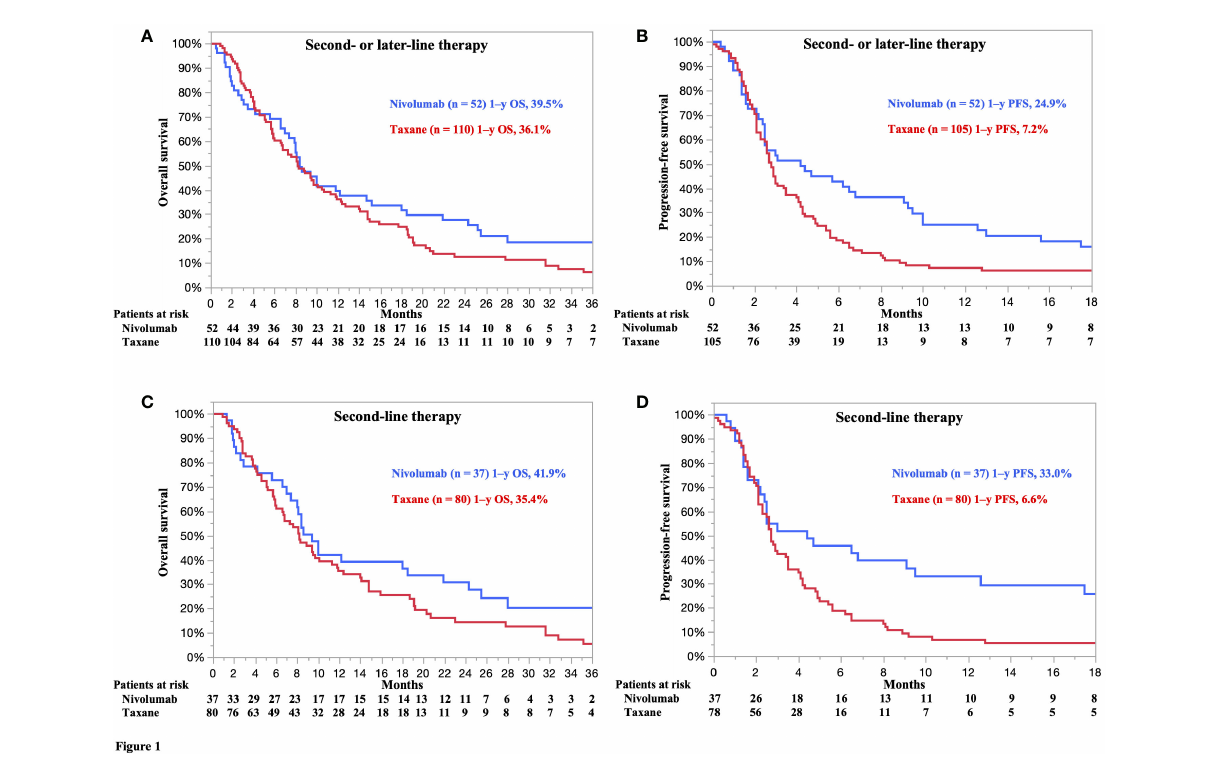
FIGURE 1 (A) Overall survival (OS) and (B) progression-free survival (PFS) of all patients treated with nivolumab or taxane as a second- or later-line treatment. (C) OS and (D) PFS of patients treated with nivolumab or taxane as a second-line treatment. Five patients without target lesions were excluded from the analysis of PFS (second-line therapy: 2 patients, later-line therapy: 3 patients). (A) Hazard ratio (HR) for death 0.82 [95% con fi dence interval (CI) 0.58 – 1.18]; p = 0.3023. Nivolumab, median 8.4 months (95% CI 7.4 – 14.7). Taxane, median 8.2 months (95% CI 6.6 – 10.5). (B) HR for death 0.64